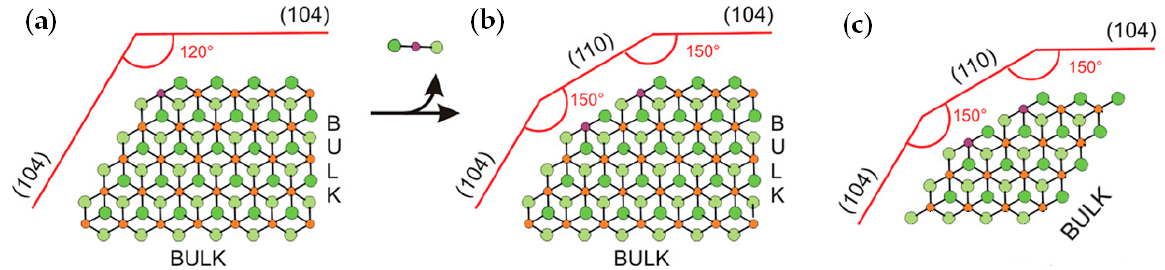
Figure 6. ( a , b ) The model for the MgCl 2 layers developed by Cavallo et al. [110]; ( c ) the modified MgCl 2 model with four layers instead of six employed in [102]. Reprinted with permission from [102]. Copyright (2014) Wiley-VCH Verlag GmbH & Co.